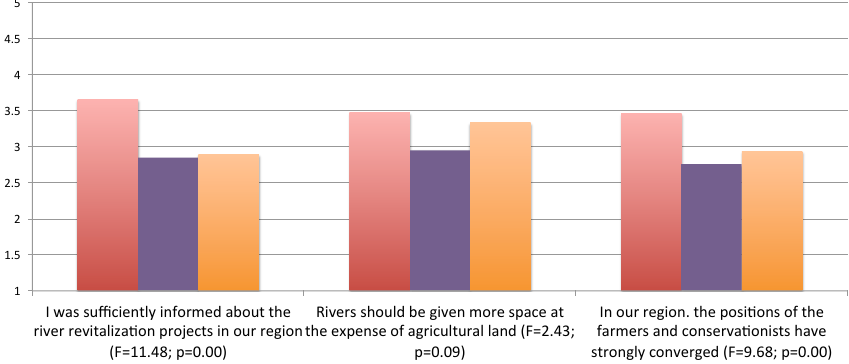
Fig. 1. Swiss inhabitants’ agreement with statements related to their or their region’s knowledge capacities, differentiated between groups with and without reported stakeholder involvement in their region. Comparison of mean values (ANOVA). N = 230.